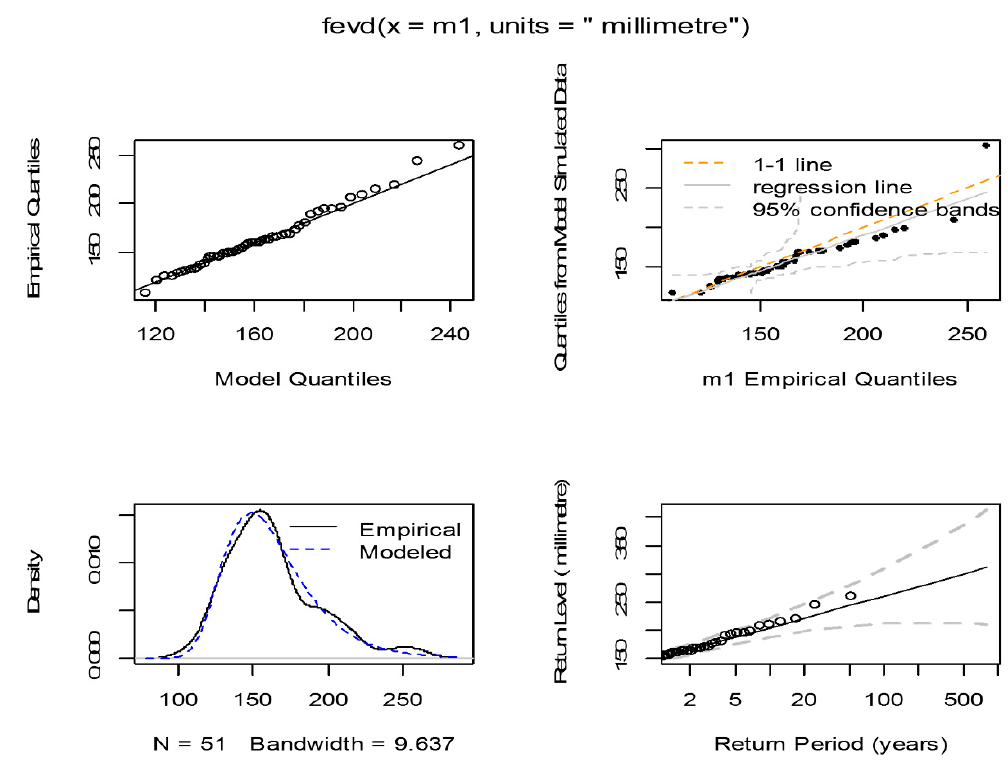
Figure 4. Diagnostic annual maximum rainfall plots.